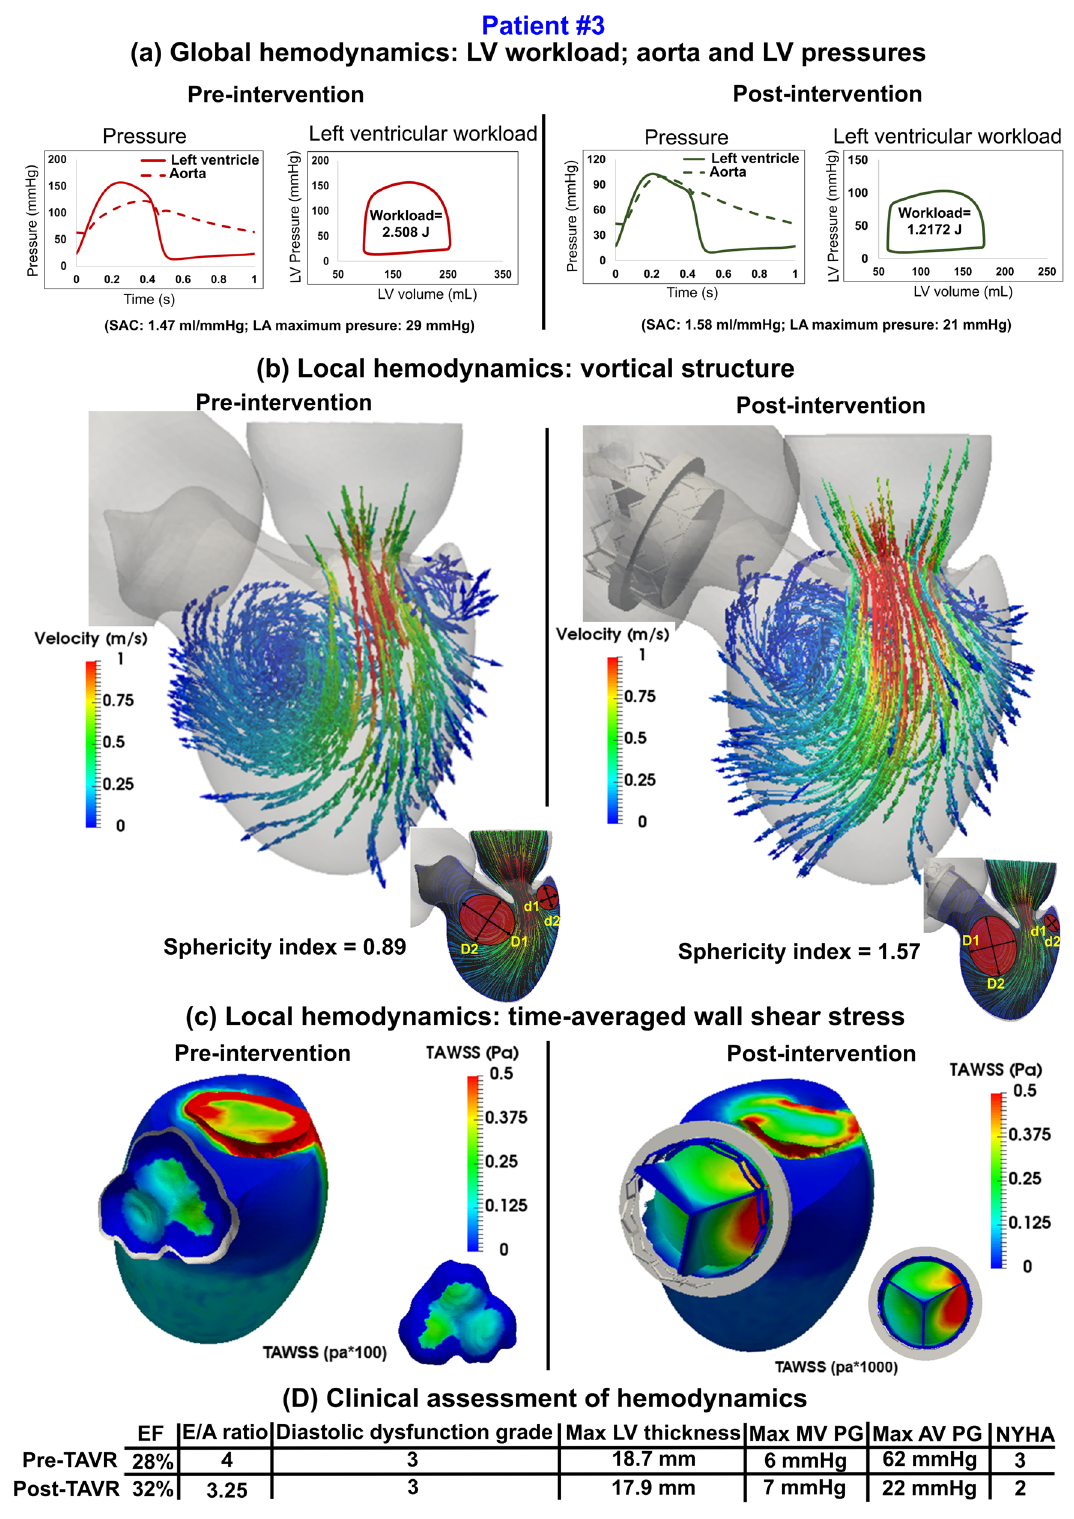
Figure 10. Changes in local and global hemodynamics in patient #3 between baseline and 90-day post-TAVR. ( a ) Global hemodynamics : LV workload, aorta and LV pressures; ( b ) Local hemodynamics : vortical structure; ( c ) Local hemodynamics : time-averaged wall shear stress; ( d ) Clinical assessment of hemodynamics. Local hemodynamics: cardiac fluid dynamics , e.g., details of the instantaneous 3-D flow and vortex formation. Global hemodynamics: (1) Metrics of circulatory function , e.g., detailed information of the dynamics of the circulatory system, and (2) Metrics of cardiac function , e.g., heart workload and the breakdown of workload contributions from each cardiovascular disease